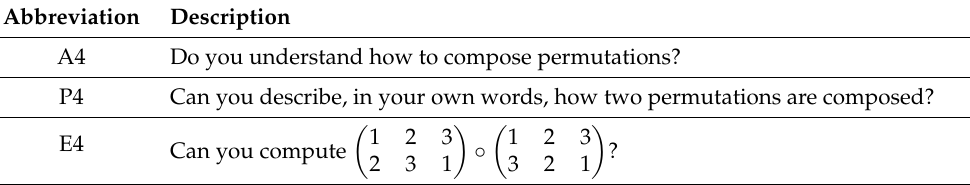
Table A4. Overview and descriptions for all units included in the interview regarding key idea 4 ( Compositions of permutations , cf. Table 1). A stands for acceptance, P for paraphrasing, and E for exercise.